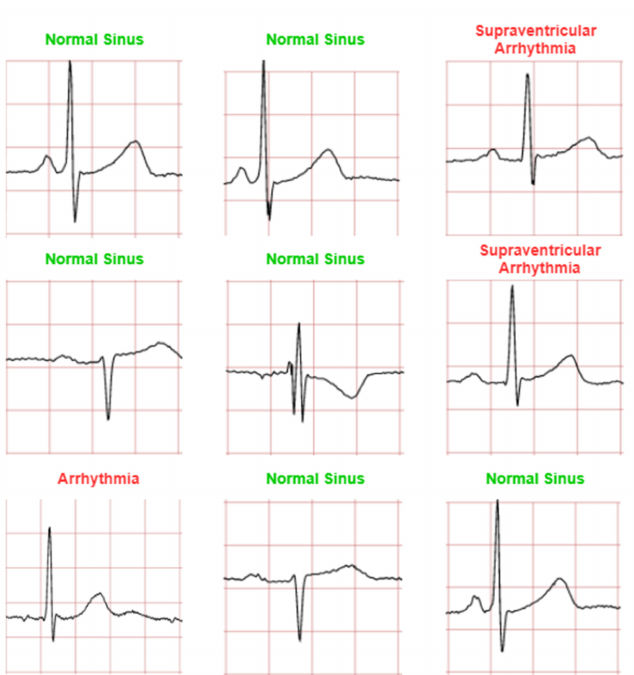
Figure 11. Prediction for ‘normal sinus’ ECG waveforms. (Note: red and green title indicated incorrect and correct prediction, respectively).